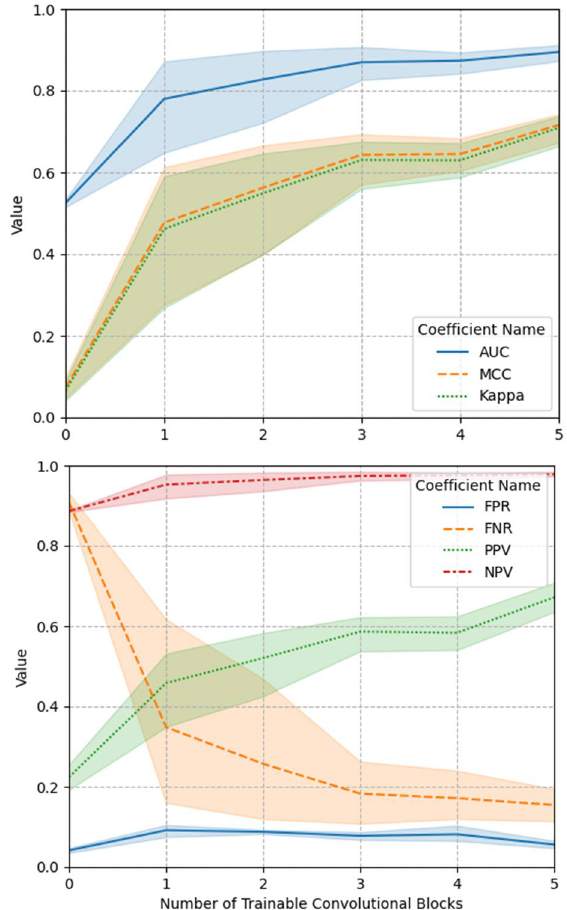
Figure 7. The changes of some indexes for model reliability (area under the receiver operating characteristic curve (AUC), Matthews correlation coefficient (MCC) and Kappa) and prediction scores (false positive (FPR), false negative (FNR), positive prediction (PPV) and negative prediction (NPV)) according to the numbers of trainable blocks in the deep CNN (VGG-16).